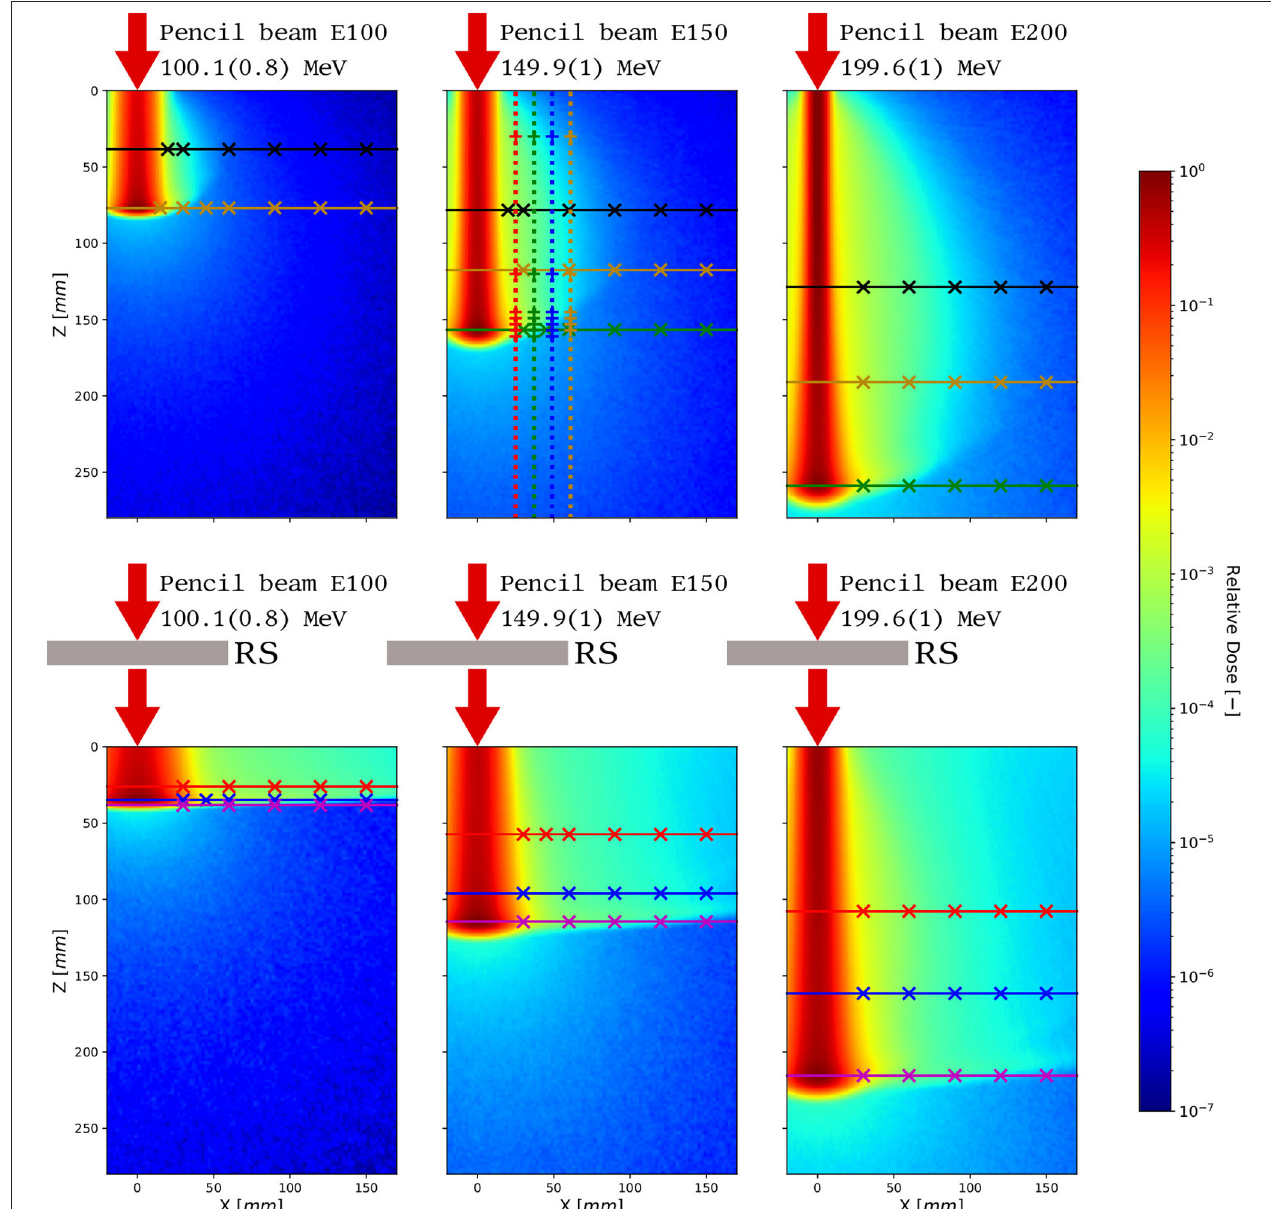
FIGURE 3 | 2D dose profiles obtained from MC simulation of proton beams at three nominal energies with (bottom) and without (top) the RS. The lateral and longitudinal dose profiles measured with M INI P IX T IMEPIX are shown, and the measurement points are marked with crosses. The color convention used to illustrate measured dose profiles is the same as the one used in the figures in the results sections 3.3 and 3.4.